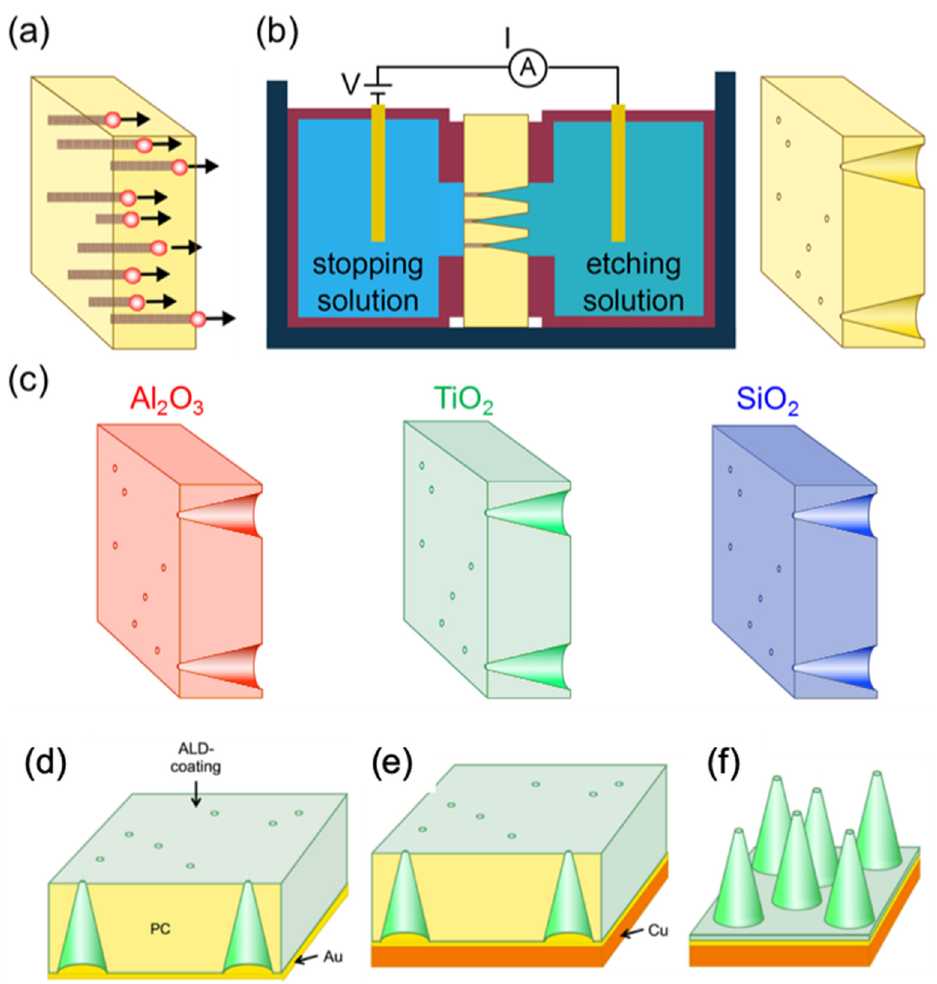
Figure 1. Fabrication of nanocone arrays by combining ion-track technology and ALD. ( a ) Swift heavy ion irradiation of polycarbonate foils, leading to parallel-oriented tracks. ( b ) Scheme of the electrochemical cell employed for asymmetric etching of the irradiated foils. Each ion track is converted into a conical nanochannel. ( c ) Conformal surface coating of etched membranes by low- temperature atomic layer deposition of Al 2 O 3 (red), TiO 2 (green), and SiO 2 (blue). ( d – f ) Fabrication steps for free-standing tubular nanocone samples. ( d ) Sputtering of Au onto the coated membrane side with large nanochannel openings. ( e ) Reinforcing the sputtered Au layer by electrodeposition of additional Cu layer. ( f ) Free-standing tubular nanocones after dissolution of the polymer template.